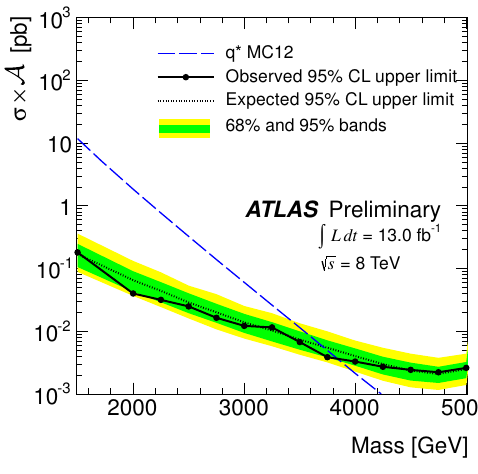
Figure 2. The observed 95% C.L. limits on σ × A as a function of m jj (black line). The black dotted line shows the expected limits with 68% (green) and 95% (yellow) confidence regions. The blue dashed line represents the q ∗ σ × A prediction [4].